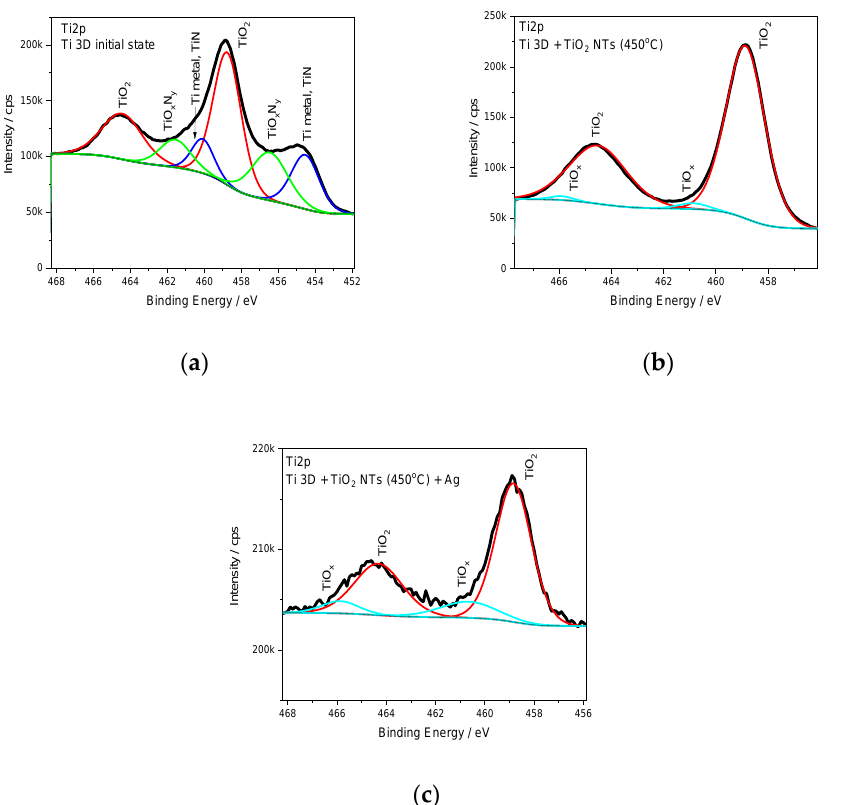
Figure 7. High-resolution XPS spectra of titanium Ti2p ( a ) for the Ti 3D substrate, ( b ) after anodic oxidation and annealing at 450 °C and ( c ) after silver deposition (0.02 mg/cm 2 ) on both substrates.